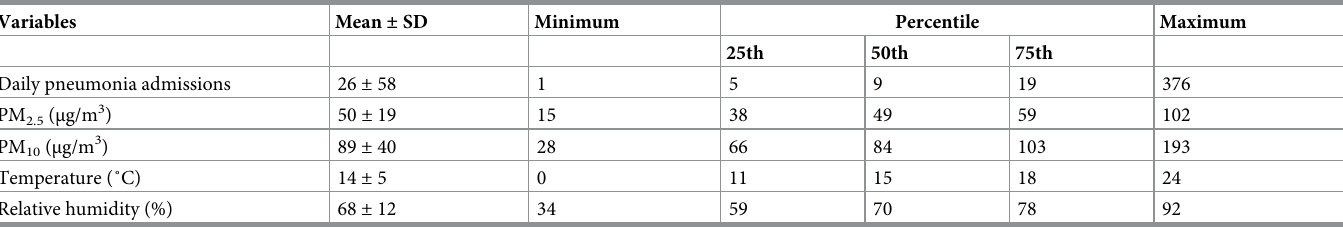
Table 1. Summary statistics of citywide annual-mean hospital admissions for pneumonia, air pollutants, and weather conditions in 184 Chinese cities, 2014–2017. Variables